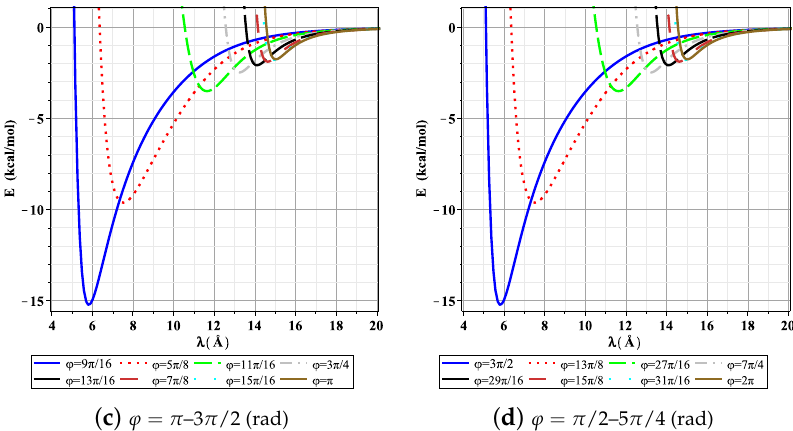
Figure 3. Energies of Cis molecules binding to DNA with respect to λ for ψ = π .